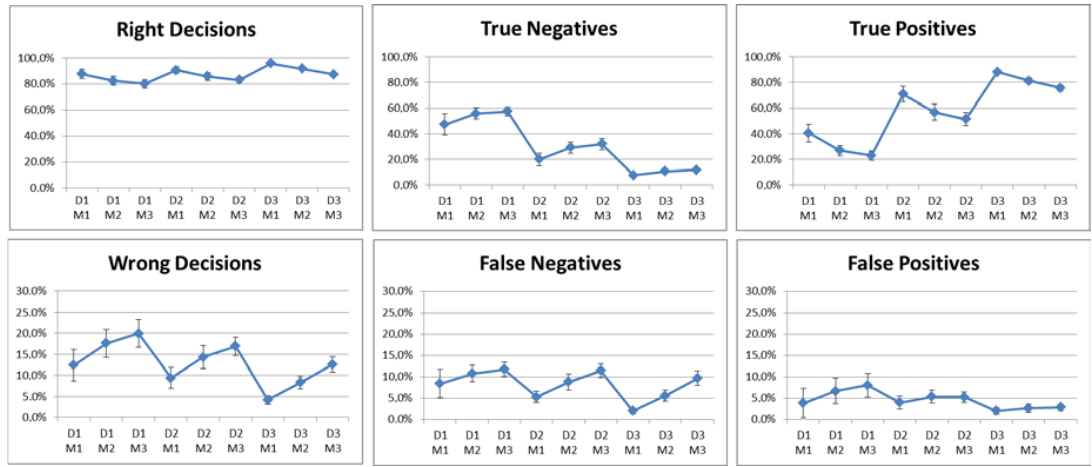
Figure 12. Newcomer attack for Manhattan-Grid Scenario experiments.